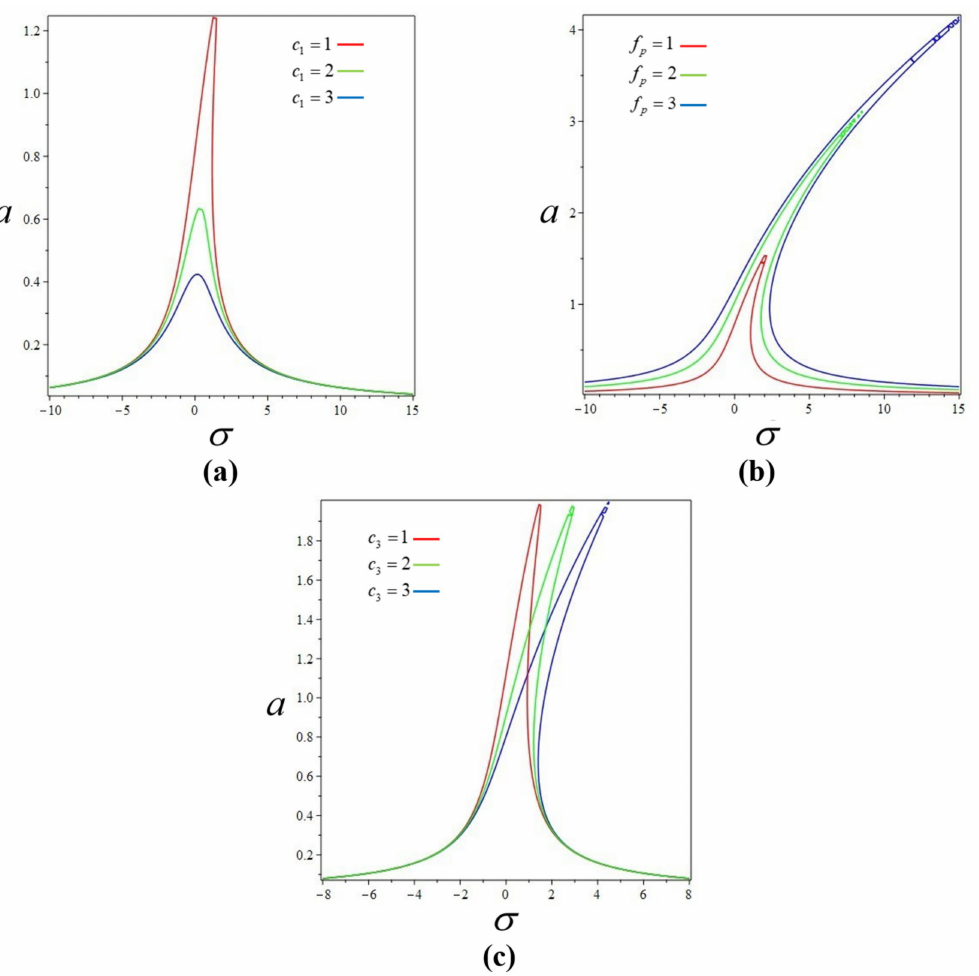
Figure 5. Frequency response for primary resonance: ( a ) different damping values, ( b ) different external excitations, ( c ) different cubic nonlinear stiffness.